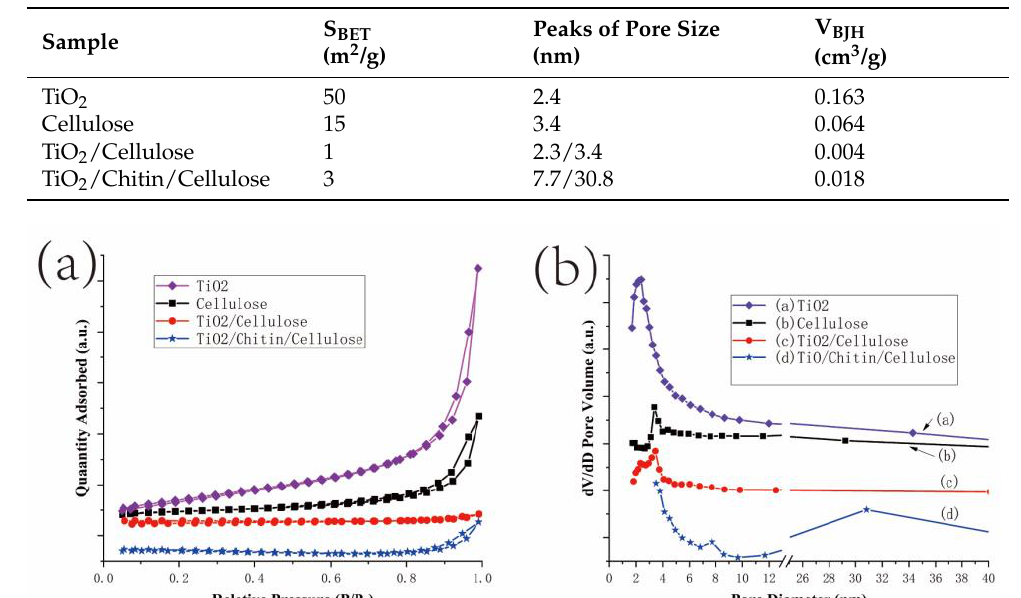
Table 1. Structural parameters of the 3D-printed TiO 2 /chitin/cellulose samples. Sample